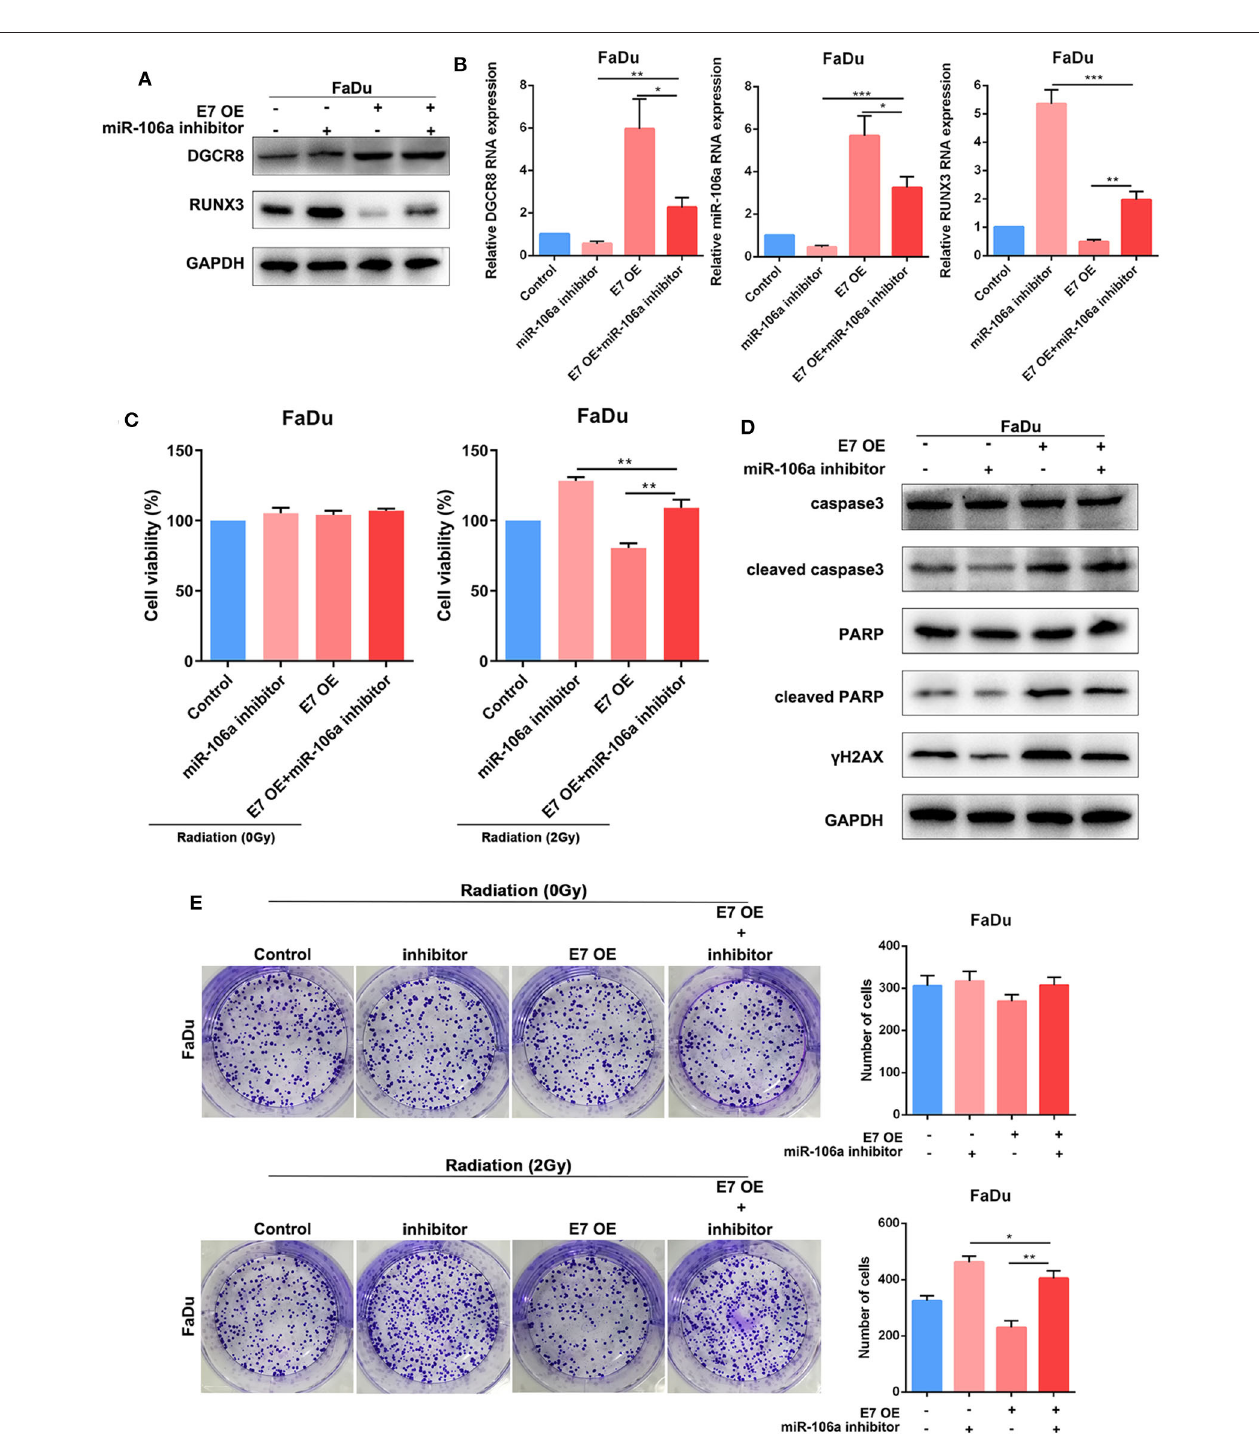
FIGURE 4 | DGCR8 inhibits the expression of RUNX3 and affects radiation sensitivity by promoting the expression of hsa-miR-106a. (A) Western blot showing rescue of RUNX3 expression level in FaDu. (B) Quantitative real-time PCR (RT-qPCR) was performed to detect DGCR8, miR-106a, and RUNX3 expression level in FaDu. (C) Cell Counting Kit-8 (CCK-8) showing rescue of cell viability in FaDu in radiation or non-radiation condition. (D) The clone formation assay showing rescue of radiation sensitivity in FaDu. (E) The protein expressions of apoptosis-related caspase-3, PARP, and DNA damage-related γ H2AX were measured by Western blot. * p < 0.05, ** p < 0.01, *** p <